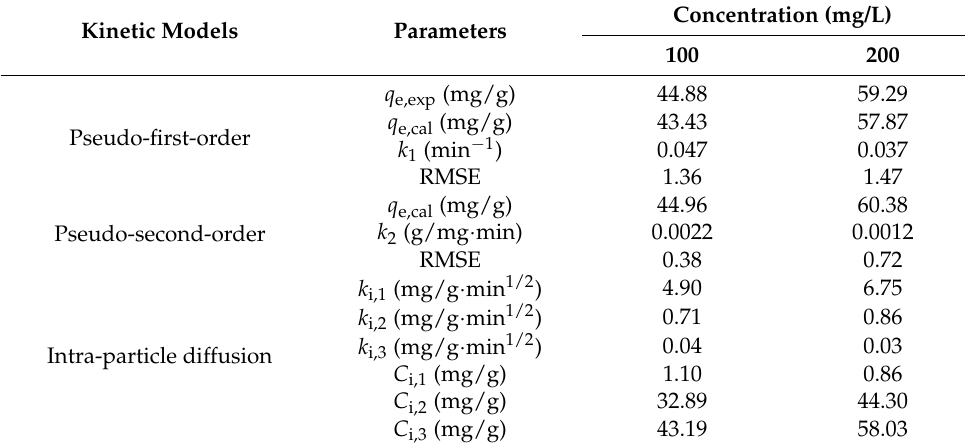
Table 1. Kinetic parameters and RMSE values for adsorption of Fe (III) on PYCS. Kinetic